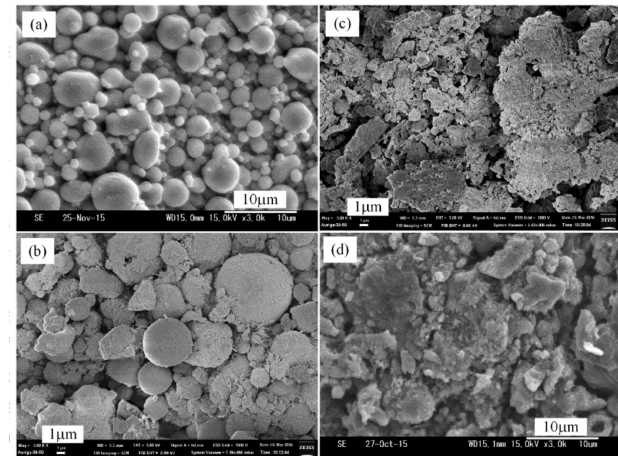
Figure 3. SEM micrographs (3000 × ) of original Al powders ( a ) and AlN/Al powders produced by thermal nitridation (Al/NH 4 Cl = 1:1, heating rate: 15 ◦ C/min) at 850 ◦ C ( b ), 950 ◦ C ( c ), and 1050 ◦ C ( d ).